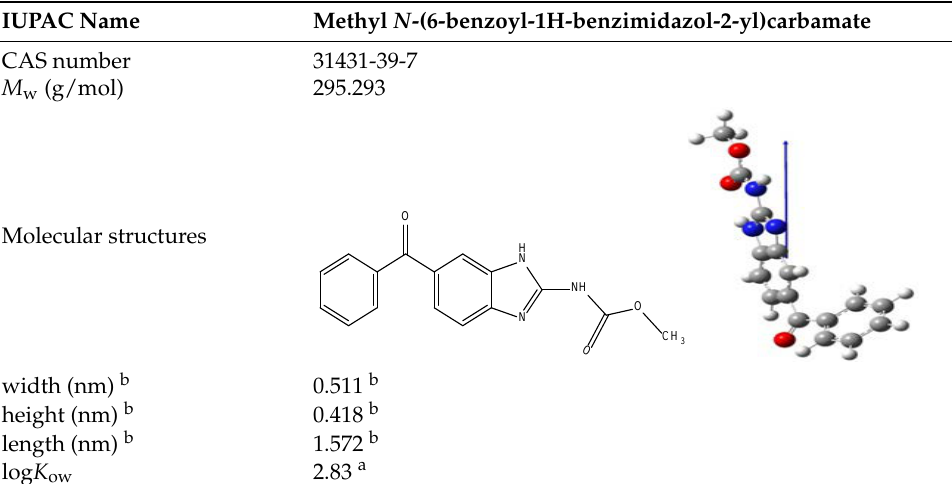
Table 1. Physico-chemical and general properties of mebendazole.